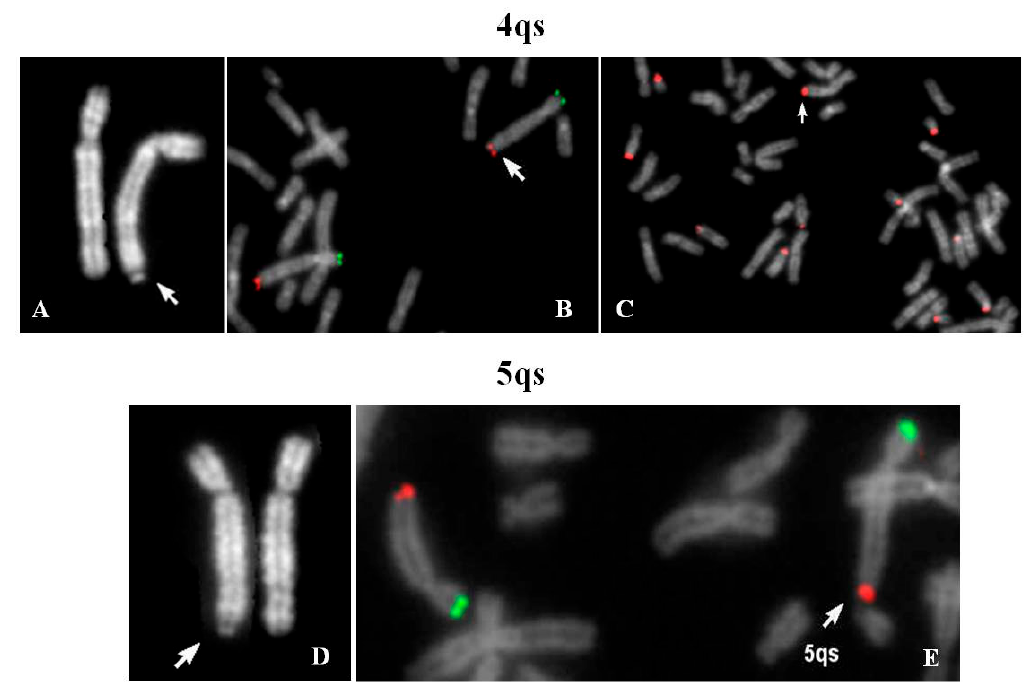
Figure 1. 4qs case 1: ( A ) Quinacrine banding (QFQ) (4qs is arrowed); ( B ) specific subtelomeric probes of chromosome 4 (green p-arm, red q-arm); ( C ) β -satellite probe (arrow indicates the 4qs chromosome). 5qs: ( D ) QFQ banding (5qs is arrowed); ( E ) specific subtelomeric probes of chromosome 5 (green p-arm, red q-arm) (arrow indicates the 5qs chromosome associated with chr 21). All images were captured at 100× magnification (see materials and methods for details).